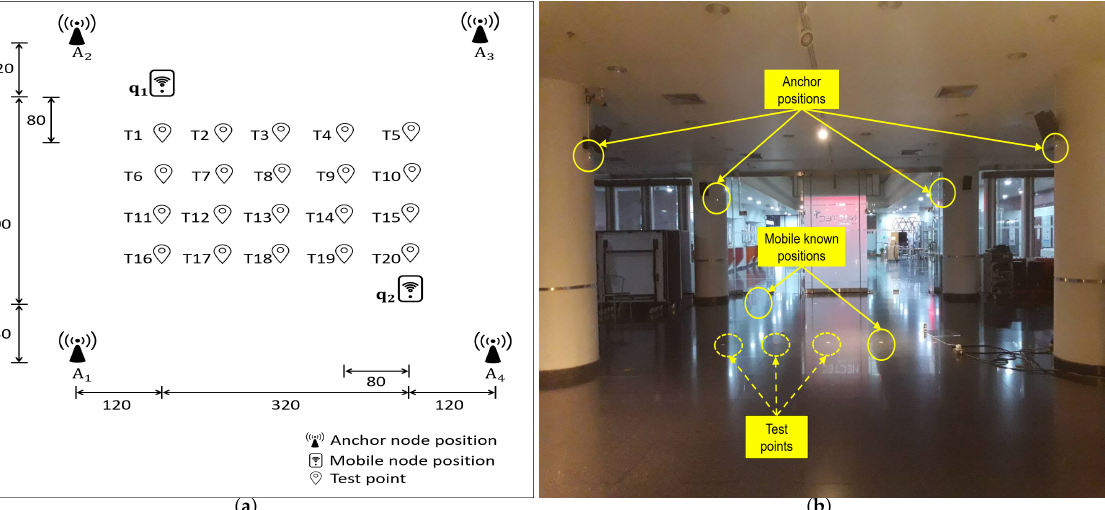
Figure 1. ( a ) Experimental layout (unit: cm). The positions of the anchor nodes, the known positions of the mobile node, and the test points for the mobile node. ( b ) Measurement and test